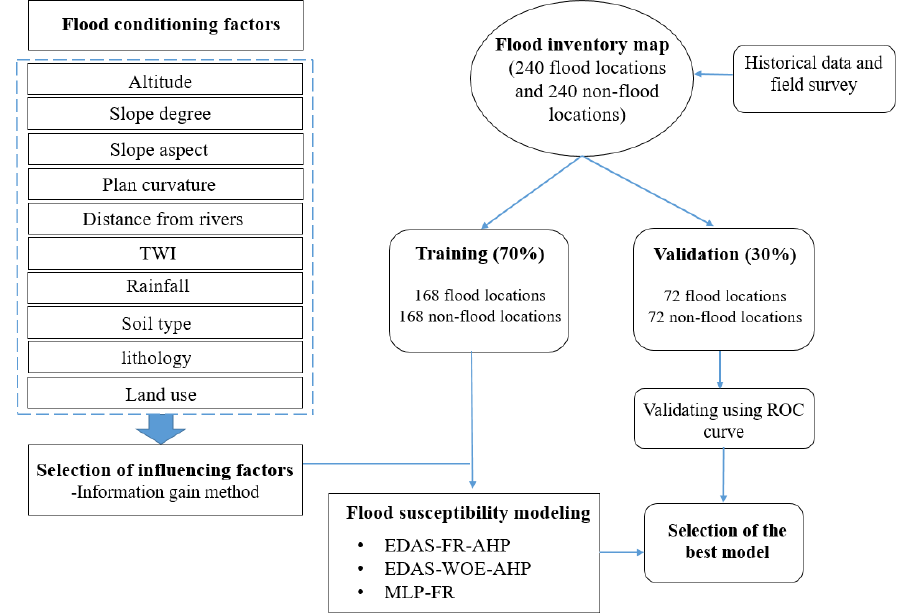
Figure 2. Hierarchy diagram of the methodology.